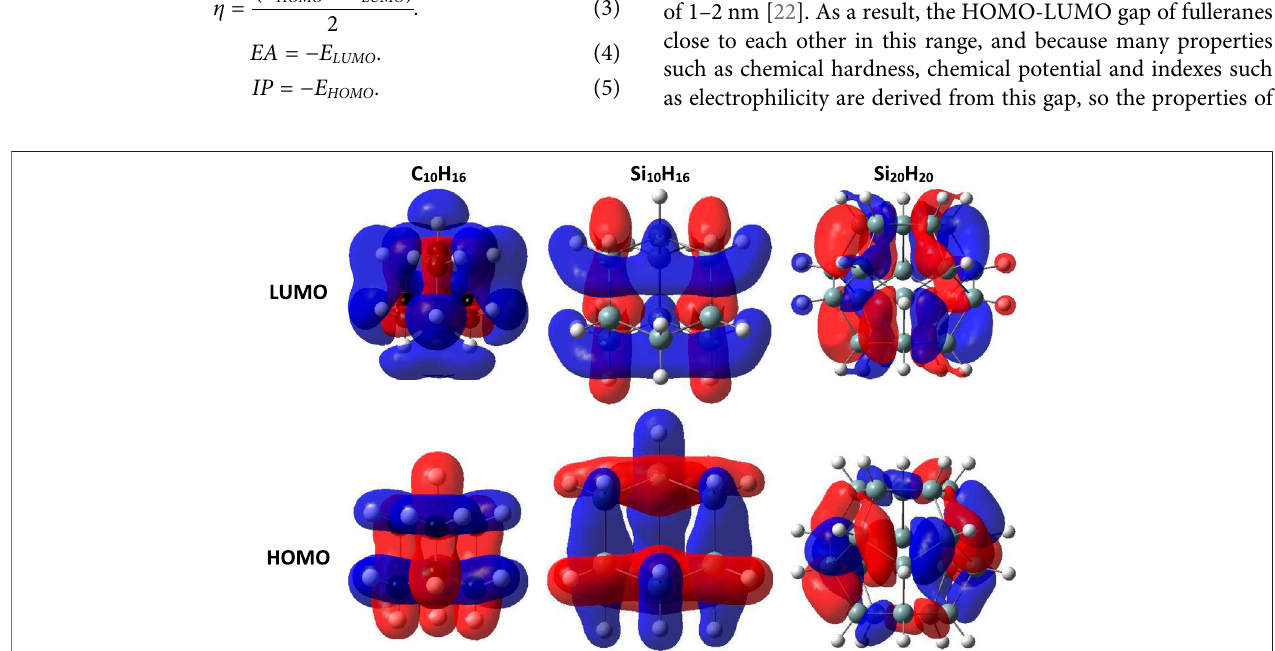
FIGURE 3 | The HOMO and LUMO orbitals for diamondoids, sila-diamondoids and sila-fulleranes (Isovalue (cid:1) 0.02).